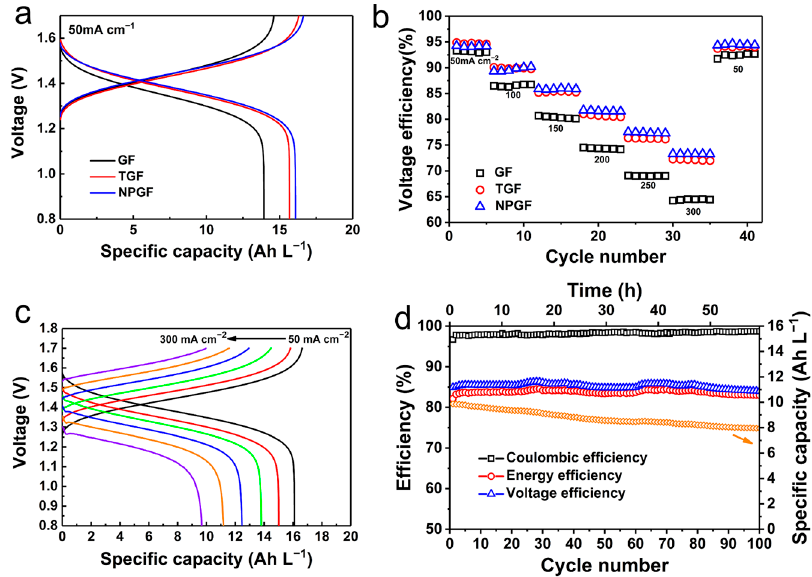
Figure 4. ( a ) Charge/discharge curves of batteries with GF, TGF, and NPGF-800 electrodes at a current density of 50 mA cm − 2 . ( b ) Voltage efficiency of VRFBs with GF, TGF, and NPGF-800 electrodes at current densities ranging from 50 to 300 mA cm − 2 . ( c ) Charge–discharge curves of VRFB with NPGF-800 as a positive electrode at a current density of 50 to 300 mA cm − 2 . ( d ) Capacity, coulombic efficiency, energy efficiency, and voltage efficiency of NPGF-800 batteries during the cycling